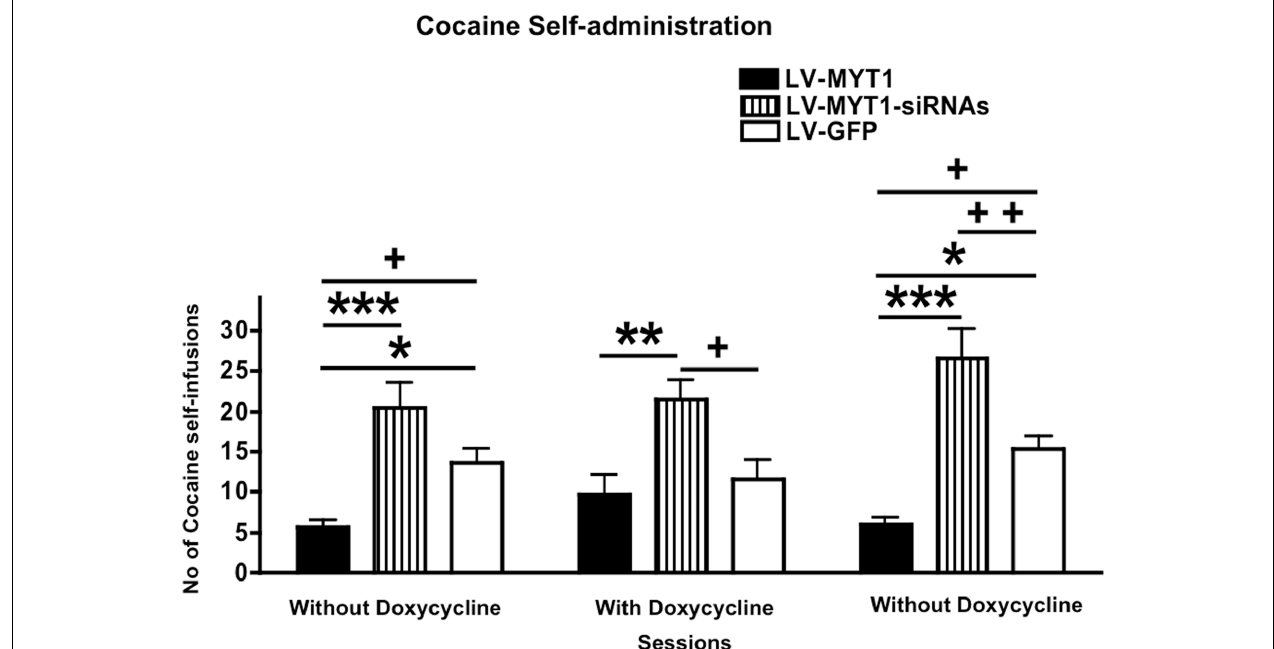
FIGURE 1 | Differential expression of NZF-2b/7ZFMyt1 in the Nucleus Accumbens (NAc) alters cocaine self-administration. Animals injected with regulatable LV-7ZFMyt1, LV-GFP and non-regulatable LV-7ZFMyt1-siRNAs were used. After surgery, recovery and training, rats ( n = 7) were subjected